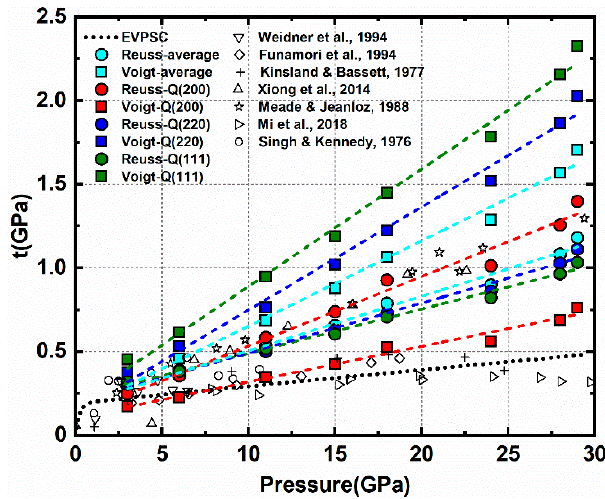
Figure 14. Differential stress of pure NaCl. Black symbols are the results from several previous studies. The dotted line is the EVPSC result from this study. Colored dash lines with filled circles and squares are the results from Equation (3) using different assumptions and lattice strains.